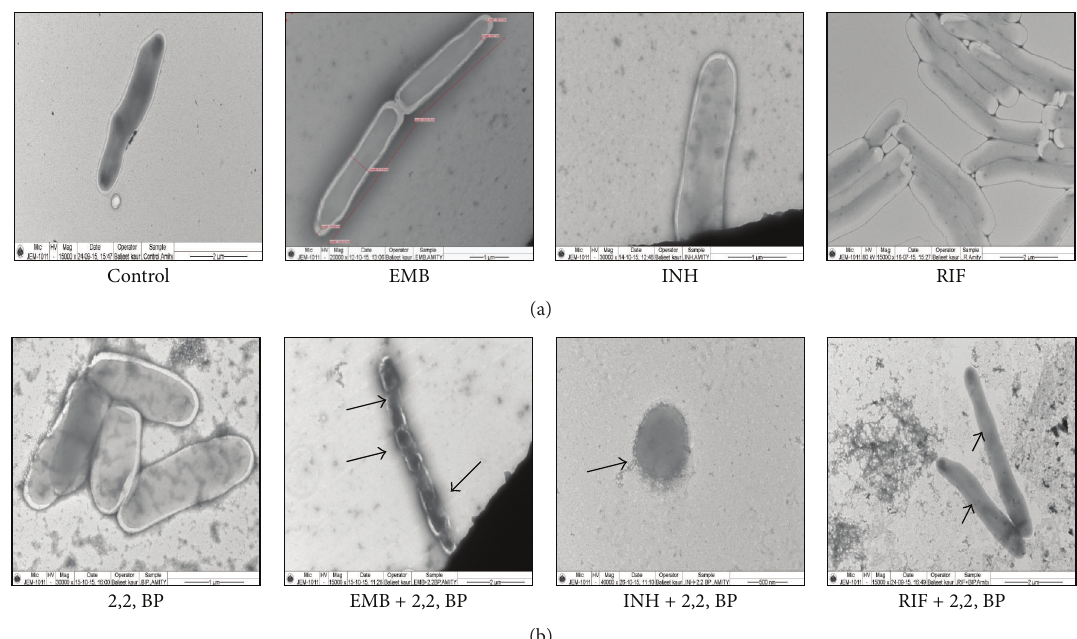
Figure 5: TEM images under iron deprivation. (a) TEM images for M. smegmatis cells grown in the absence (control) of 2,2, BP (35 𝜇 g/mL) anddrugsEMB,INH,andRIFwithsubinhibitoryconcentrations(62.5ng/mL,1 𝜇 g/mL,and62.5 ng/mL)aloneshowingsmoothcellenvelope. (b) TEM images for M. smegmatis cells grown in the presence of drugs (EMB, INH, and RIF) with subinhibitory concentrations (62.5 ng/mL, 1 𝜇 g/mL, and 62.5 ng/mL) along with 2,2, BP (35 𝜇 g/mL) showing tampered and elongated